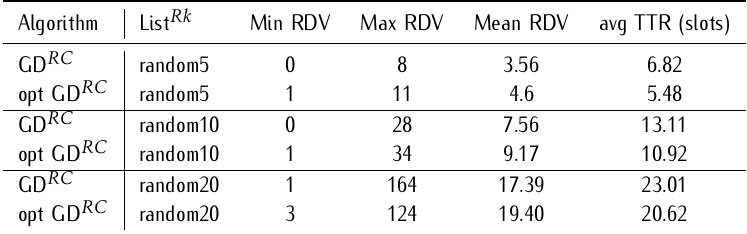
Table 6. Slot synchronized CRs, random scenarios: Minimum (Min), Maximum (Max), average (Mean) number of potential RDVs per cycle, and average TTR (slots) for gQS and optimized gQS schemes; List Rk is the channel ranking lists